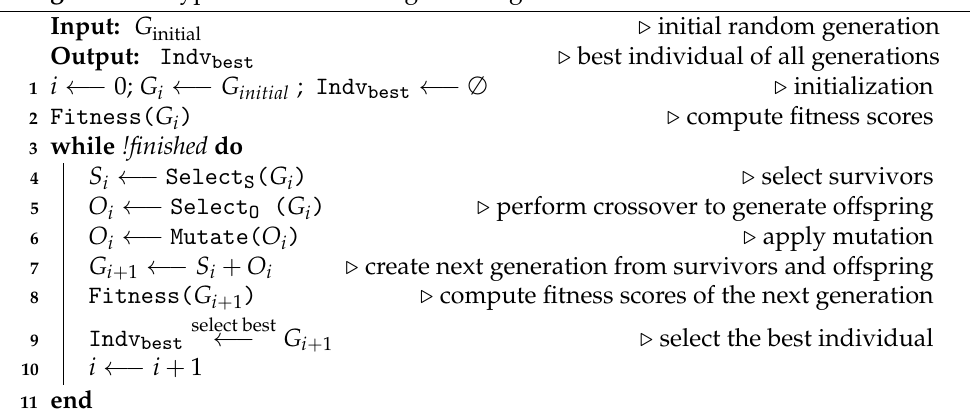
Algorithm 1 Typical structure of a genetic